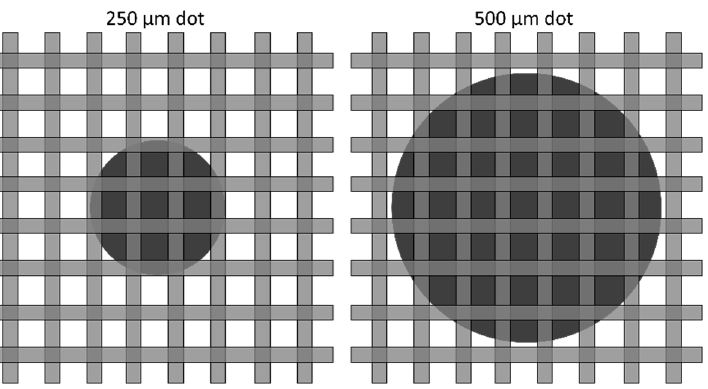
Figure 20. 250 μ m and 500 μ m dots compared to 325 mesh. Dots and mesh are shown to scale. Figure 20. 250 µ m and 500 µ m dots compared to 325 mesh. Dots and mesh are shown to